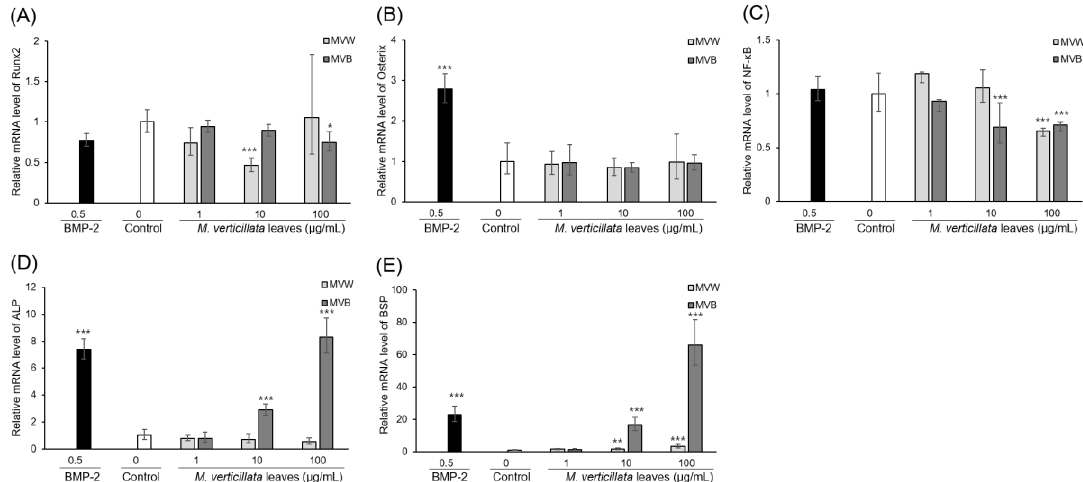
Figure 5. Effects of MVW and MVB on gene expression related to osteoblast differentiation in C3H10T1/2 cells. C3H10T1/2 cells were treated with MVW and MVB, cultured for 9 days, and harvested. Total RNA was isolated from the cells, and the cDNA was synthesized using the total RNA as a template. The mRNA expression of marker genes for osteoblast differentiation was measured by RT-PCR. The osteogenic markers are ( A ) Runx2, ( B ) Osterix, ( C ) NF-κB, ( D ) ALP, ( E ) BSP. Significant differences compared with the controls: * p < 0.05, ** p < 0.01, *** p < 0.001 .